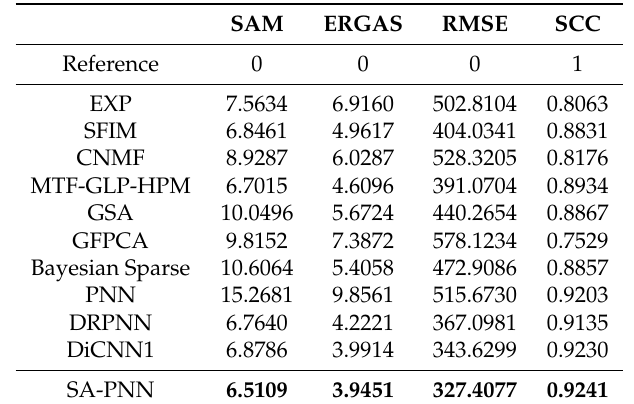
Table 5. Quality indexes at reduced resolution on a 150 × 75 sub-scene of the Pavia dataset (best result is in